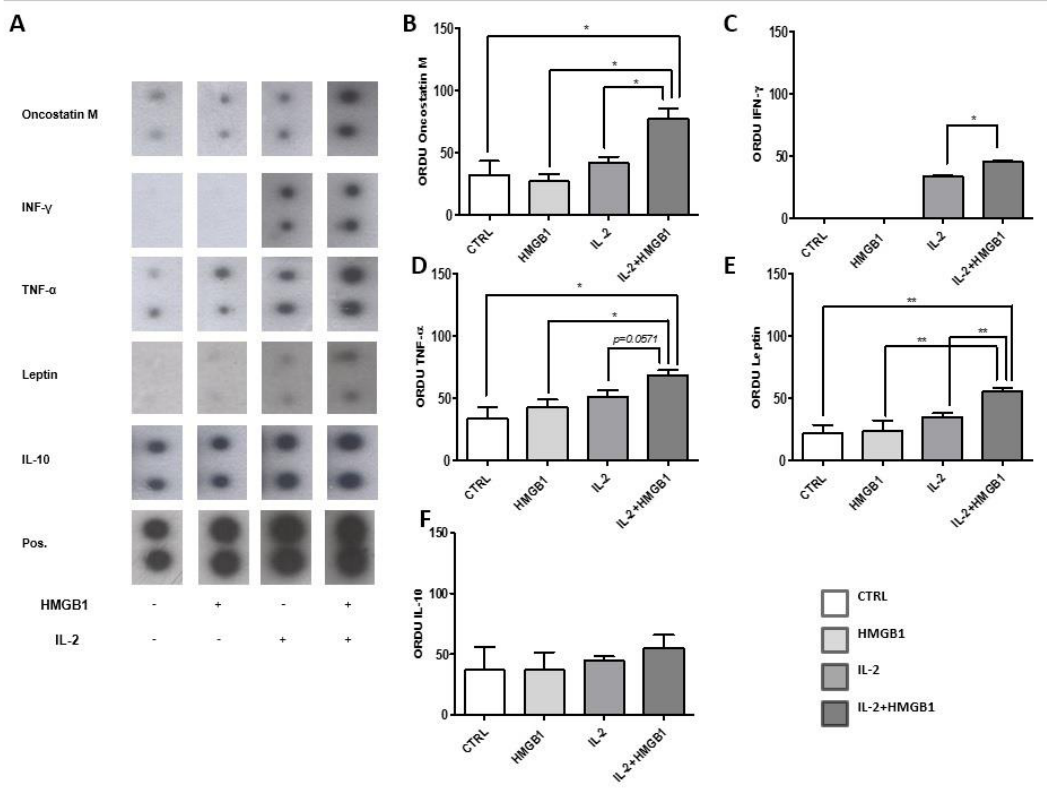
Figure 1. ( A ) Cytokine secretion was evaluated by Western blot assay on PBMCs supernatants. IL-2/HMGB1co-treatment induced a significant increase in the secretion of reported pro-inflammatory cytokines; ( B ) Oncostatin M; ( C ) INF − γ ; ( D ) TNF- α ; ( E ) Leptin. Treatment with HMGB1 or IL-2 alone did not induce any significant variation in pro-inflammatory cytokines release, except INF- γ , which increased in response to IL-2; ( F ) IL-10 levels were not modified in response to the different treatments; ORDU (optical relative density unit) has been calculated by percentage expressed ratio between optical cytokine absorbance vs. positive control displayed in ( A ). Data are expressed as mean ± SEM for four healthy donors and were analyzed with Wilcoxon–Mann–Whitney U Test (* p < 0.05, ** p < 0.005). CTRL: control; HMGB1: High Mobility Group Box1; IL-2: Interlukin-2; INF − γ : Interferon − γ ; TNF- α : Tumor Necrosis Factor- α ; IL-10: Interlukin-10; Pos: